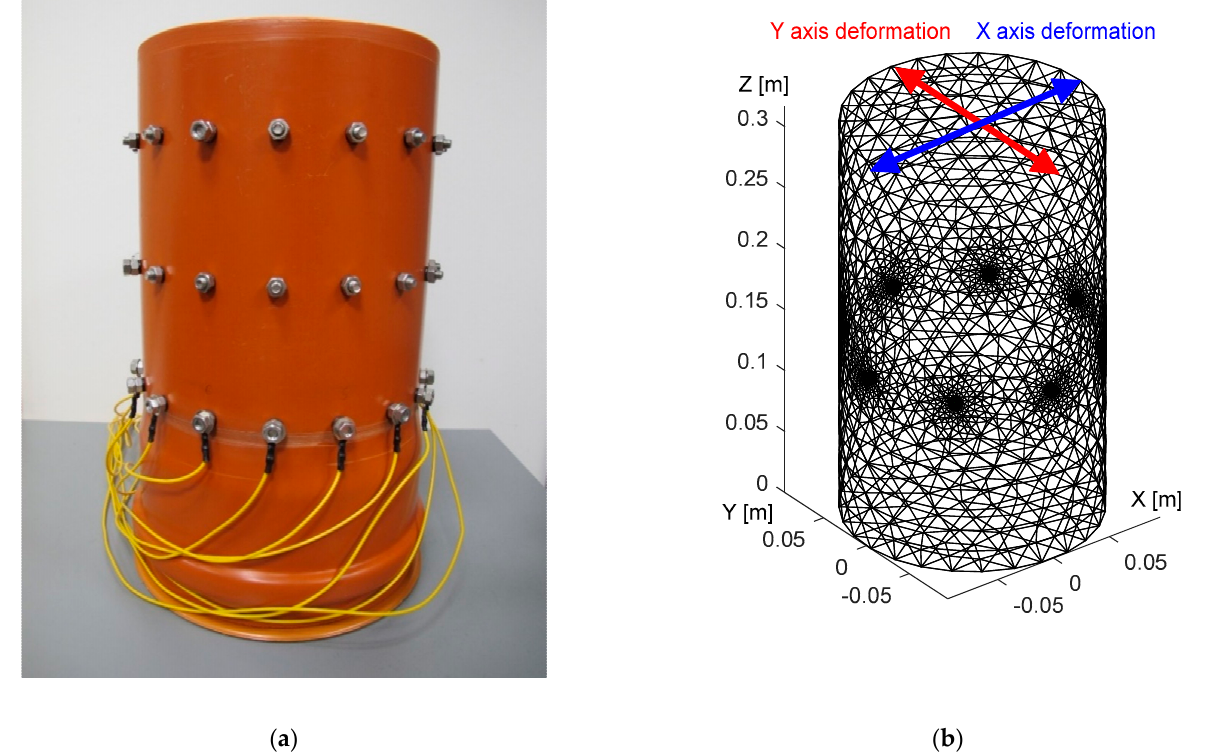
Figure 5. The images: ( a ) the laboratory setup; ( b ) the Netgen-based numerical model.